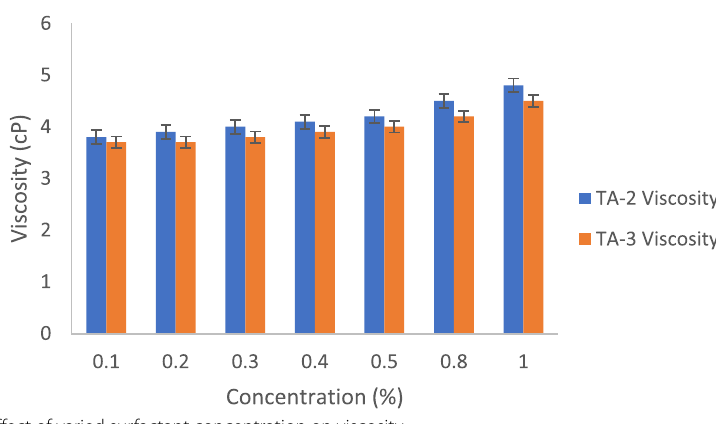
Fig. 4 Effect of varied surfactant concentration on viscosity